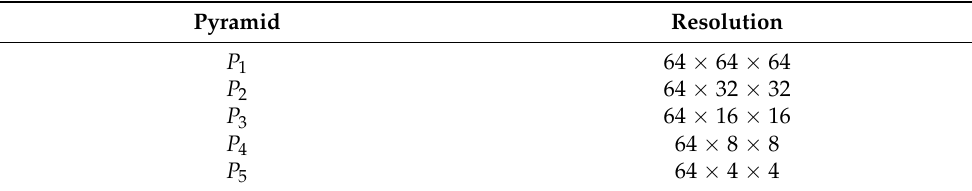
Table 2. Resolutions of the five convolutional feature